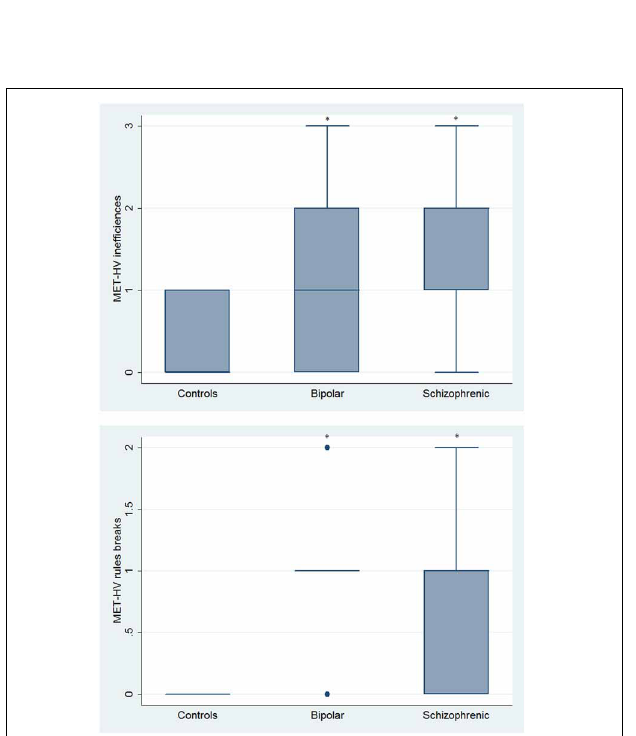
FIGURE 9 | Differences between groups in ESCB tasks: MET-HV Inefficiencies and Rule Breaks. • Outliers. ∗ Significantly different from HC ( p < 0 . 05).